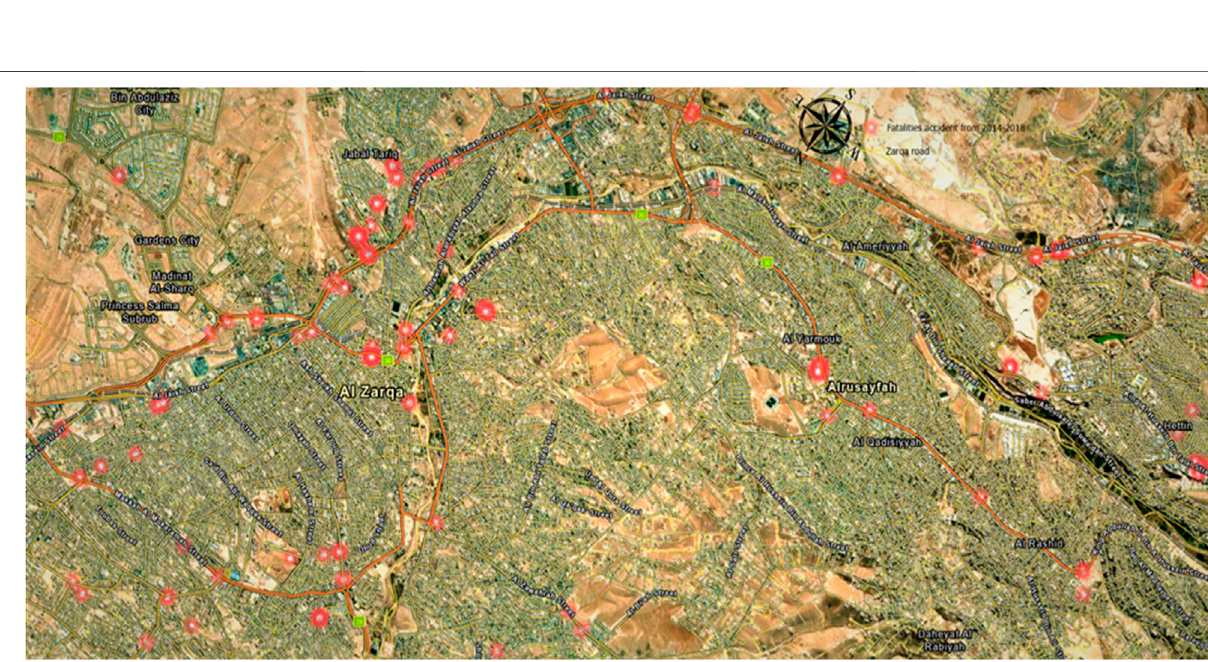
FIGURE 5 | Detailed sample of Optimized Hot spot Analysis on King Al Hussein Bin Talal Street.